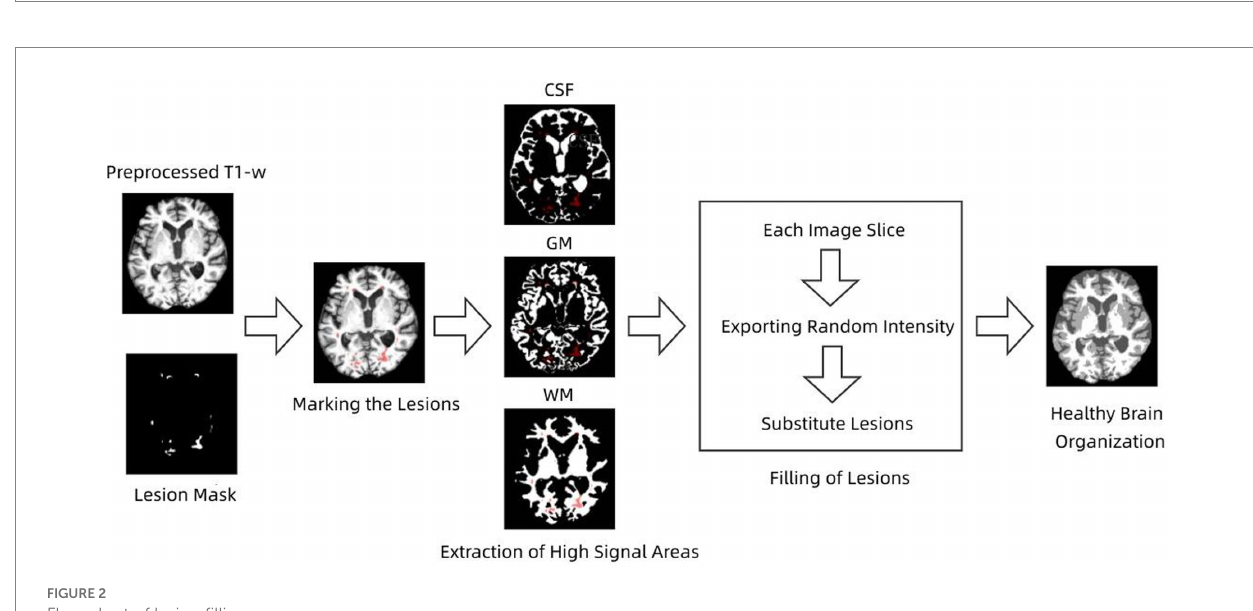
FIGURE 2 Flow chart of lesion